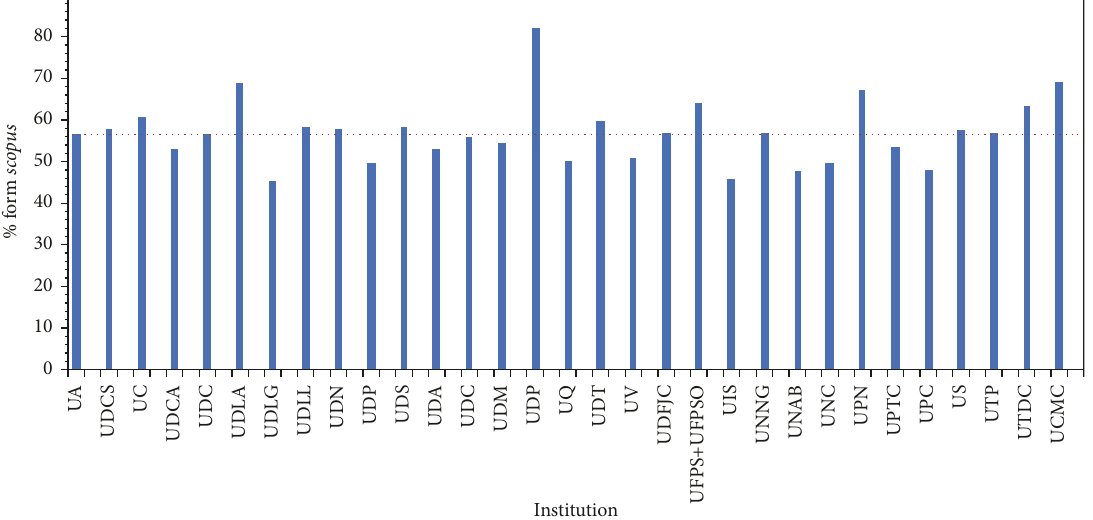
Figure 6: Percentage of collaborative documents of universities in Colombia.